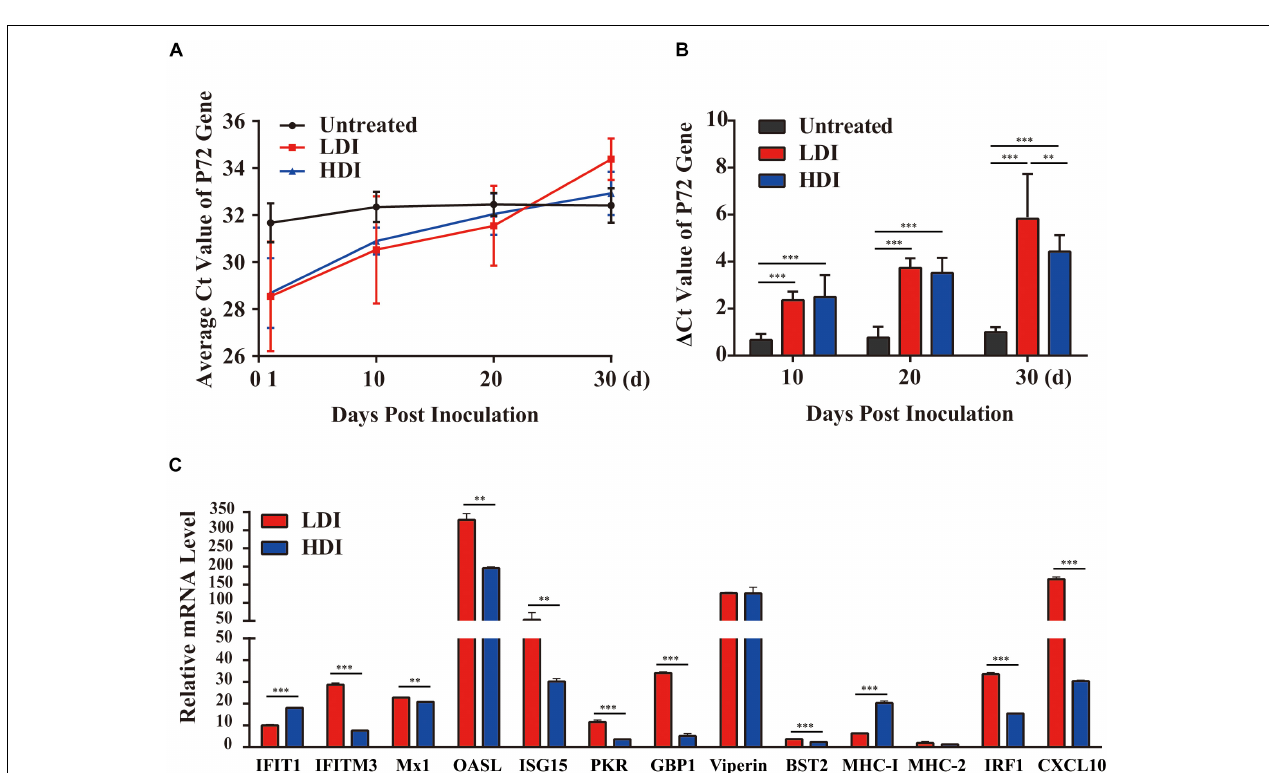
FIGURE 3 | African swine fever virus (ASFV) P72 Ct values at the indicated time points in PoIFN- α - and PoIFN- γ -treated surviving pigs after ASFV infection. Groups included PBS (Untreated), low-dose PoIFN- α and PoIFN- γ combined (LDI, 1 × 10 6 U/kg), and high-dose PoIFN- α and PoIFN- γ combined (HDI, 1 × 10 7 U/kg). (A) The average Ct value of the P72 gene was recorded for each group. (B) The increase in the (cid:49) Ct value of the P72 gene was determined for each group. Data are representative of the mean ± SDs ( n = 3). A non-parametric test was used for the difference significance analysis. (C) Gene expression in pig peripheral blood lymphocyte induced with PoIFN- α and PoIFN- γ . Anticoagulant peripheral blood was drawn from pig and lysed in TRIzol Reagent for RNA extraction. The vertical axis shows the relative transcription level (fold-change) of IFN-stimulated gene (ISG) expression comparing the negative control and treated groups. The fold-changes were measured by the 2 − (cid:49)(cid:49) Ct method, and RNA levels were normalized. Three replicates were performed for q-PCR verification analyses. Bars represent the means ± SDs ( n = 3). A non-parametric test was used for the difference significance analysis. Statistically significant differences are indicated ( ∗∗ P < 0.01; ∗∗∗ P < 0.001) and the line above the column marks the two groups with